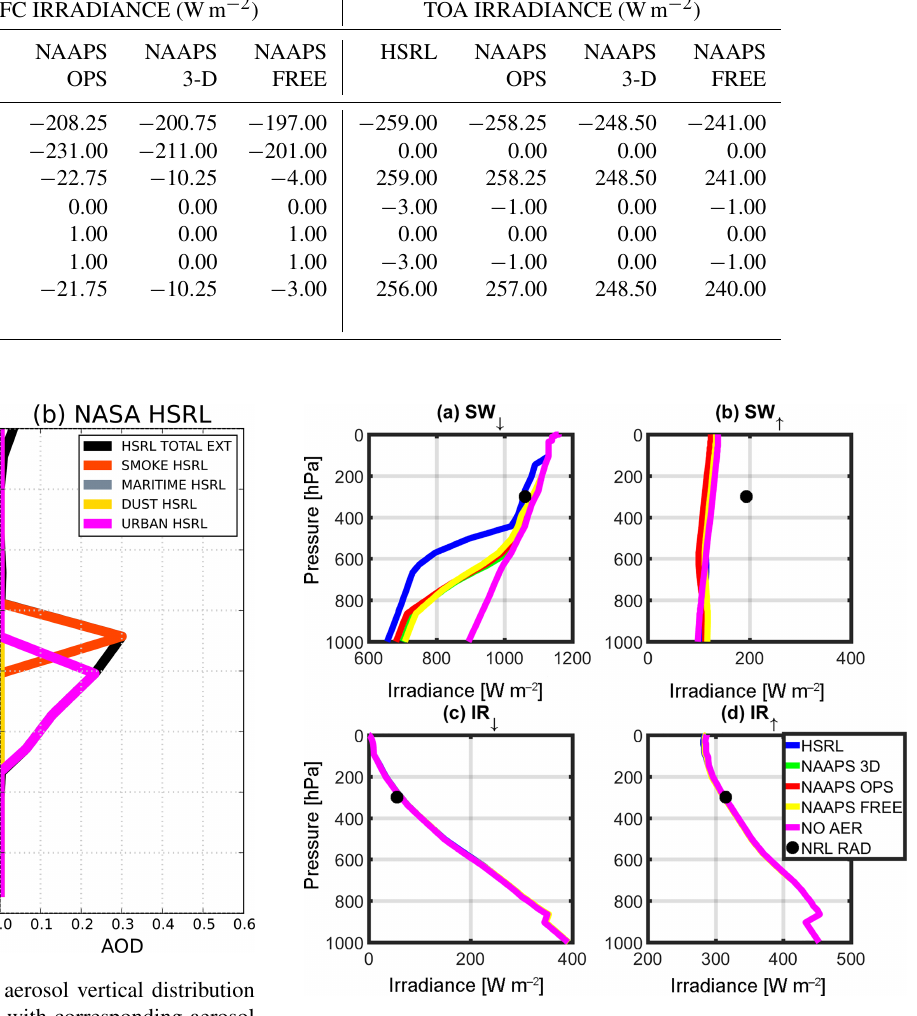
Figure 3. Irradiance calculation results for the (a) SW ↓ , (b) SW ↑ , (c) IR ↓ , and (d) IR ↑ using the MSPI 555µm reflectance value retrieved for the Thunder Basin case study, 19 August 2013 (BRF =